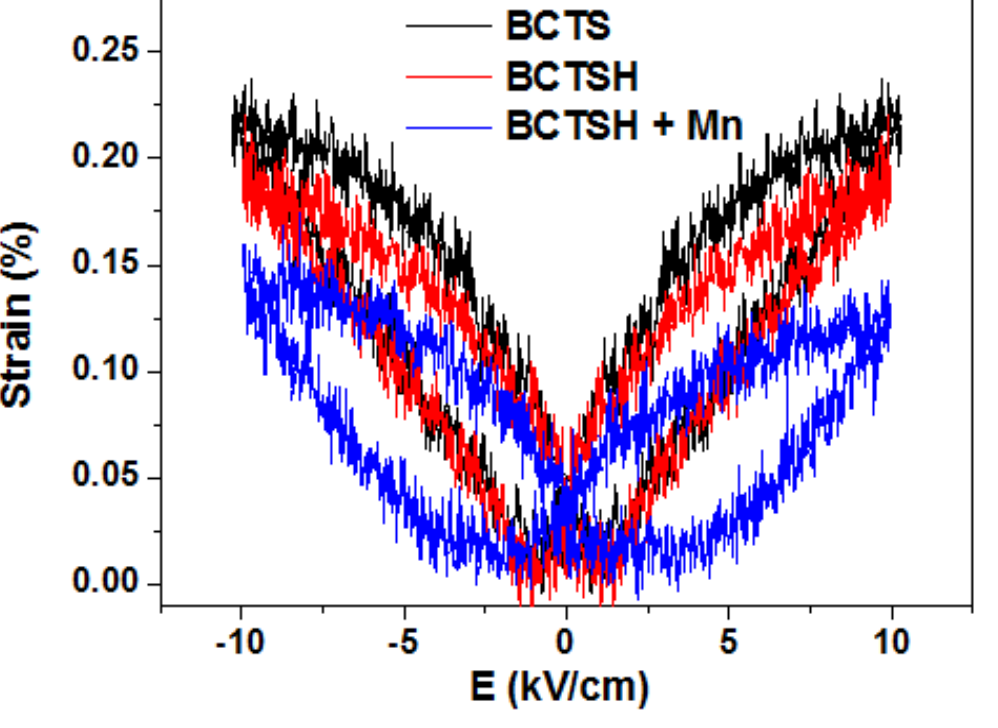
Figure 6. Bipolar strain-electric field (S − E) loops for BCTS, BCTSH and BCTSH + Mn ceramics.